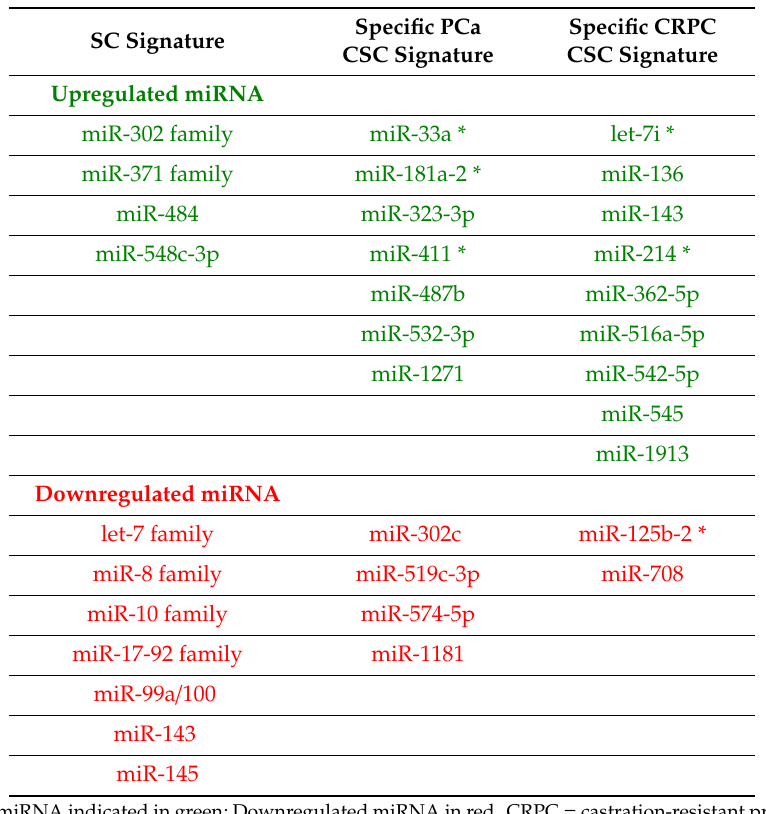
Table 3. Principal miRNA classes implicated in prostate epithelial cell di ff